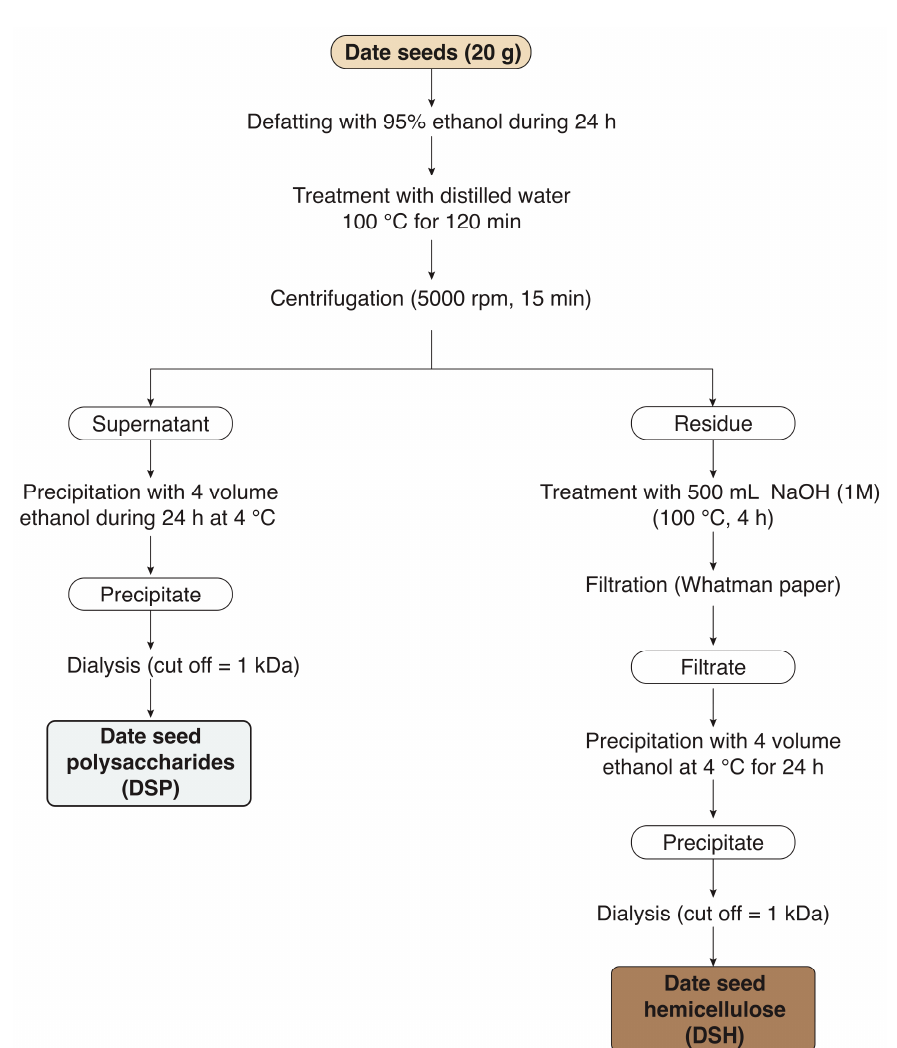
Figure 1. Extraction steps of the water-soluble polysaccharides (DSP) and hemicellulose (DSH) from the date seeds of the varieties Deglet Nour, Ghars Souf, and Allig.